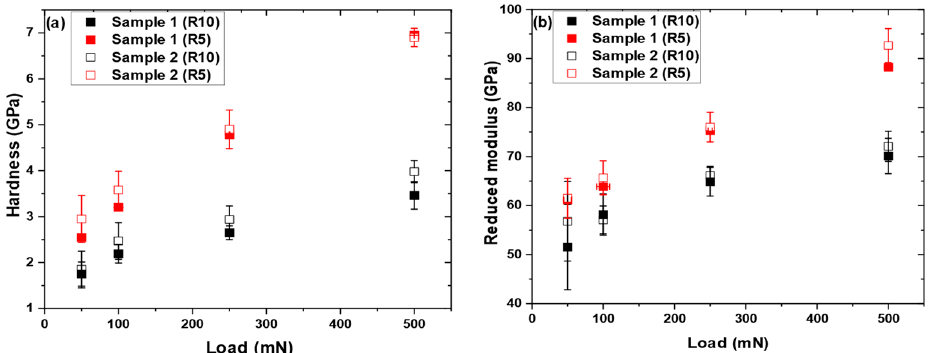
Figure 6. ( a ) Hardness and ( b ) reduced modulus of samples 1 and 2 at various loads with indenter radii of 5 and 10 μ m.